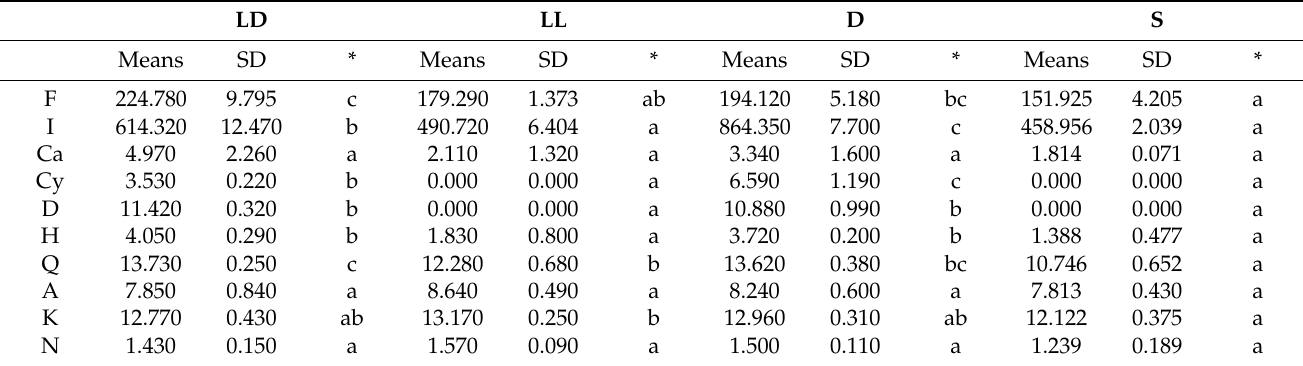
DW, respectively. Table 1. Concentration of flavonoid ‡ in micrograms per gram DW (µg/g DW) obtained by HPLC-UV quantitative analysis of ethanolic extract of Agave lechuguilla bagasse dried under different conditions ∫ . LD LL D S Means